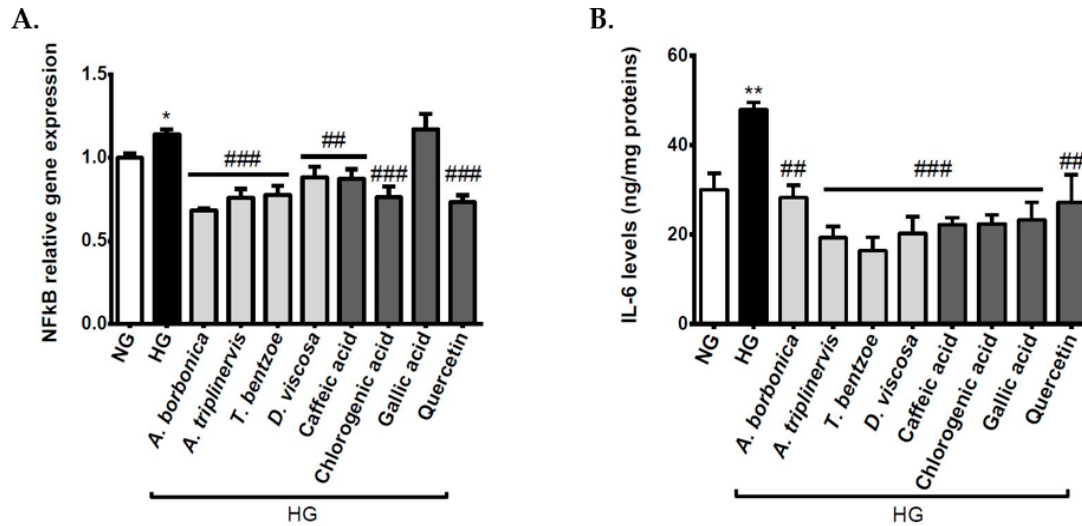
Figure 5. E ff ect of polyphenols on the production of inflammatory markers on cerebral endothelial cells in hyperglycemic condition. The cells were exposed to normoglycemic condition (NG) or hyperglycemic condition (HG) in the presence or not of each polyphenol-rich plant extract (10 µ M GAE) or standard polyphenol (10 µ M). The expression of NF κ B gene was measured by RT-qPCR and normalized to GAPDH gene expression ( A ). The secretion of IL-6 was measured by ELISA kit ( B ). Data are means ± SEM of three independent experiments. *: p < 0.05 and **: p < 0.01 as compared to NG. ##: p < 0.01 and ###: p < 0.005 as compared to HG.